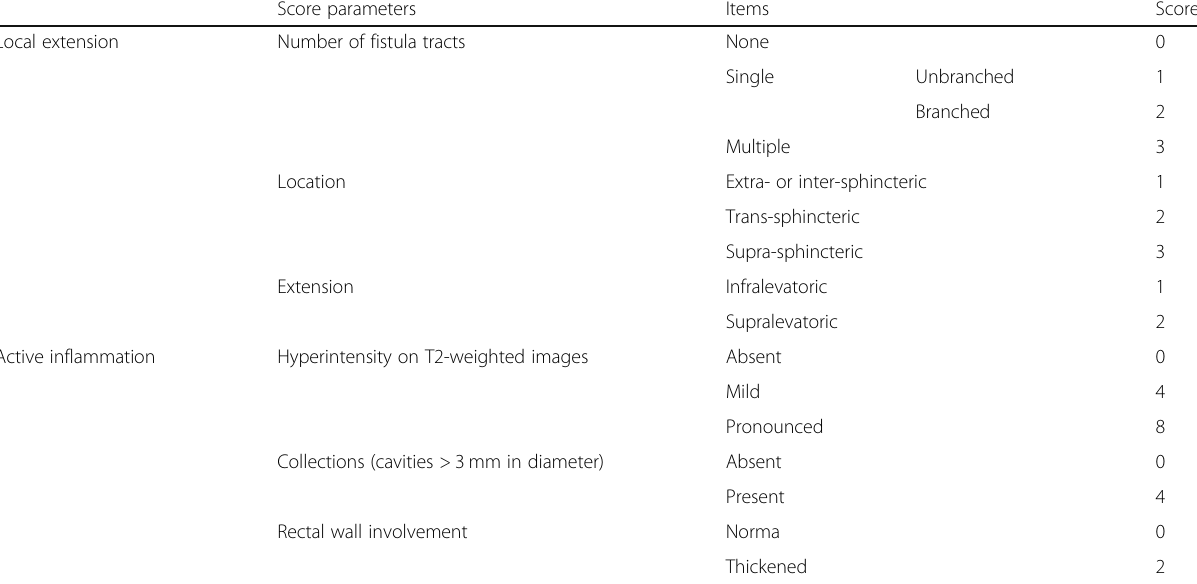
Table 1 MRI-based Van Assche scoring system